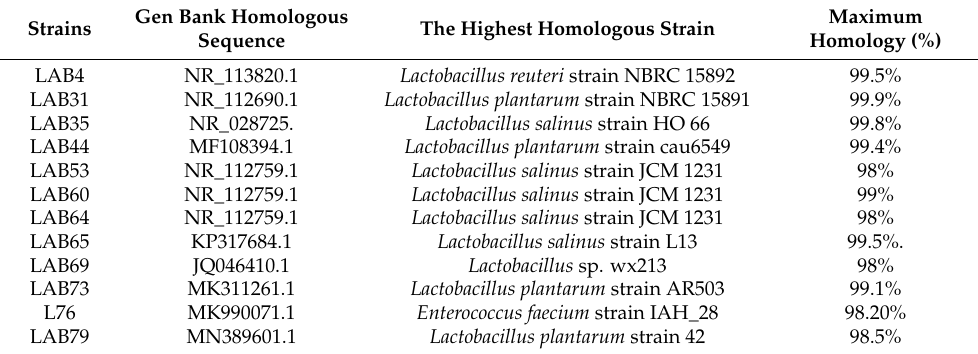
Figure 6. Neighbor-joining phylogenetic tree based on 16 S rRNA gene sequences showing relationship between Lactobacillus isolates. Table 5. 16S rDNA sequence analysis results of